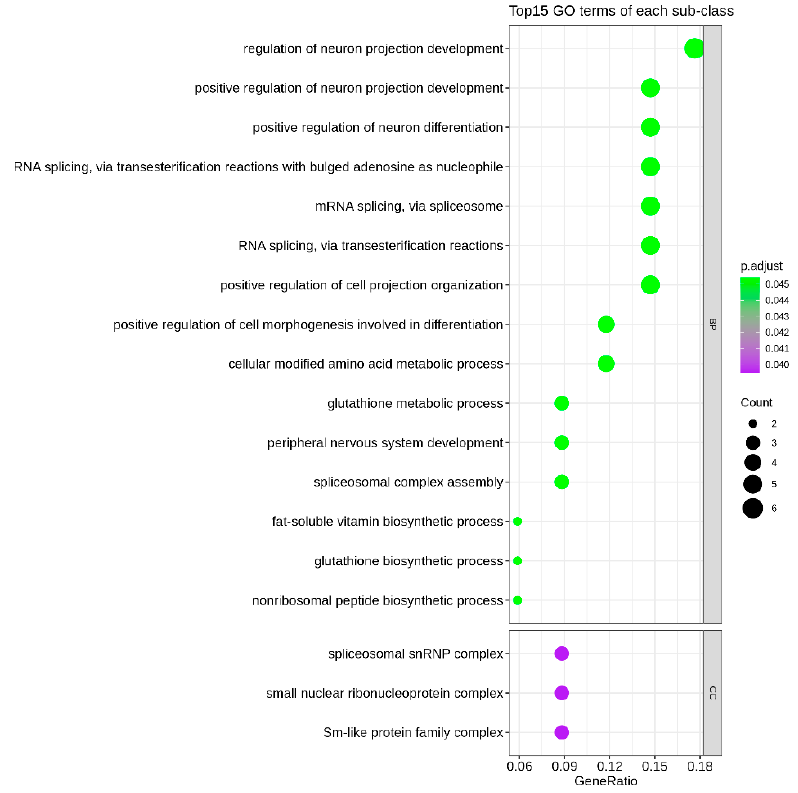
Figure 3. The top 15 enriched GO terms for the identified 37 genes using the clusterProfiler pack- age.